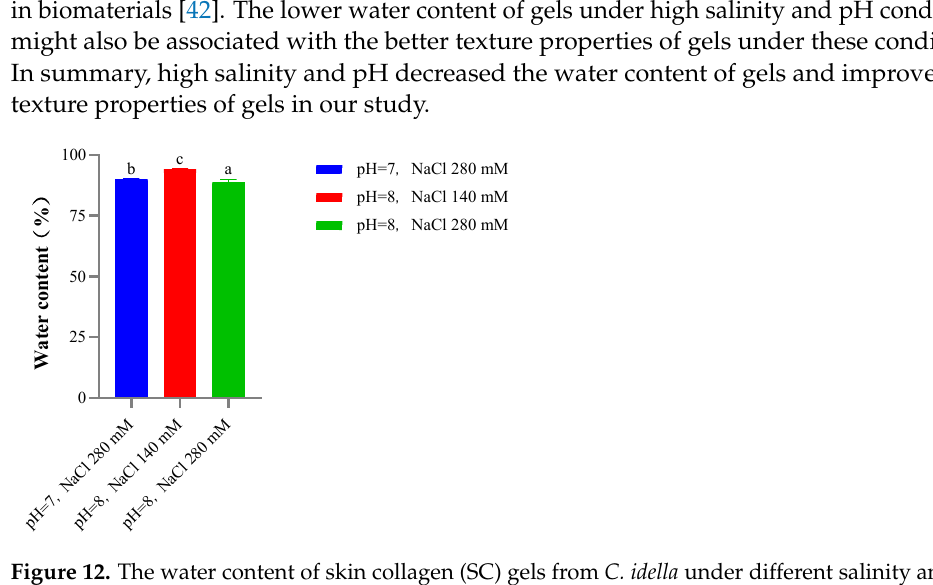
Figure 12. The water content of skin collagen (SC) gels from C. idella under different salinity and pH. a,b,c represents significant differences ( p < 0.05).